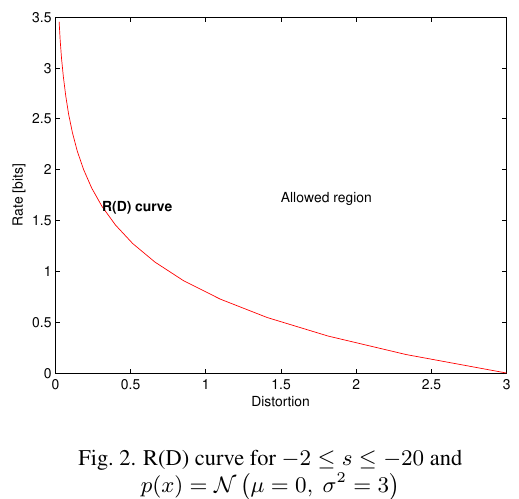
Fig. 2. R(D) curve for − 2 ≤ s ≤ − 20 and